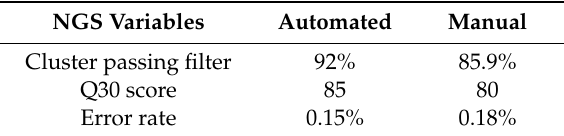
Table 5. Comparison of performance parameters of libraries prepared by manual and automated